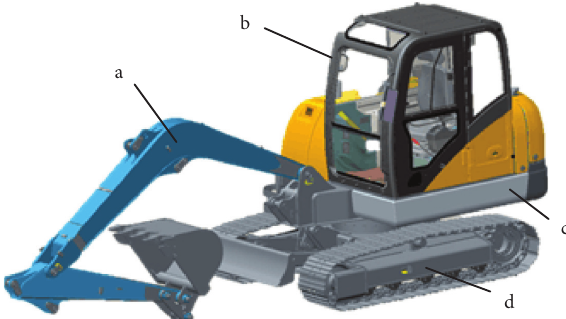
Figure 1: CLG906D tracked hydraulic excavator. (a) Working device. (b) Cab. (c) Rotary platform. (d) Walking